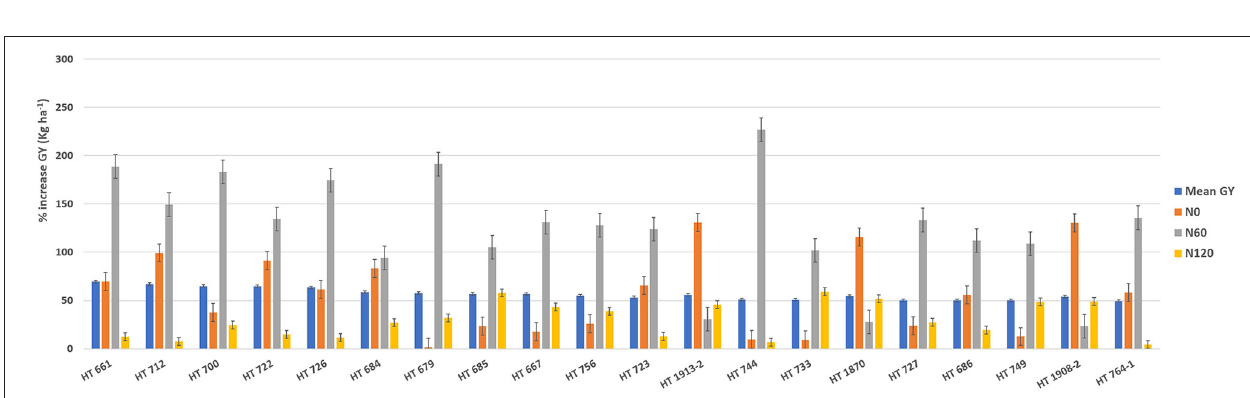
FIGURE 8 | The percentage increase in the grain yield (GY) of top 20 breeding lines derived from the nested introgression libraries possessing high and stable GY (kg ha − 1 ) compared to the respective recipient parent averaged across two seasons under three different nitrogen (N) treatments. The numeric values above the bar graph indicate the mean GY (kg ha − 1 ) performance of breeding lines across